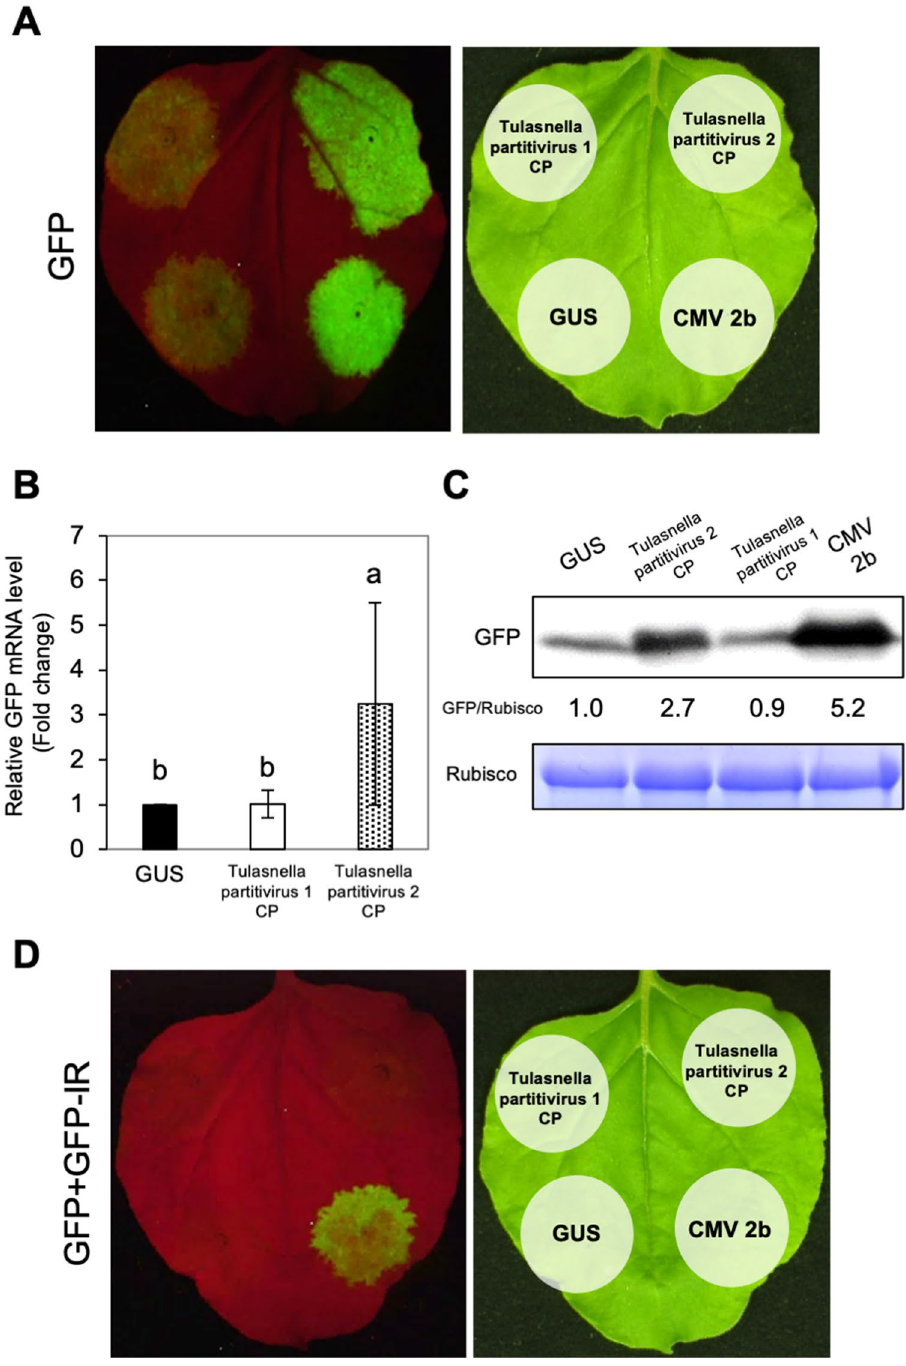
Figure 4. RSS activity of partitivirus CPs derived from OM fungi. ( A ) Assessment of RSS activity of the partitivirus CPs against sense RNA-mediated GFP silencing. Tulasnella partitivirus 1 CP or Tulasnella partitivirus 2 CP was expressed with GFP in N. benthamiana leaves by agroinfiltration. RSS activity of partitivirus CPs was assessed by comparing GFP intensities under UV light at 5 days post agroinfiltration (dpa). ( B ) Real-time RT-PCR for comparison of relative GFP transcript levels. The leaf samples from agroinfiltrated patches were collected at 5 dpa. Data were compared as values of fold-change relative to the control (GUS), and the values were analyzed on log-transformed data by Tukey’s multiple test (* P < 0.05). Means and confidence intervals are shown in the graph. Different letters above the bars indicate a significant difference among the experimental groups. ( C ) Western blot analysis to compare GFP levels using anti GFP antibodies. The Rubisco large subunit (Rubisco) is shown as a loading control for each sample. ( D ) Assessment of RSS activity of the partitivirus CPs against dsRNA-mediated GFP silencing. Each partitivirus CP was expressed with GFP and GFP-IR in N. benthamiana leaves by agroinfiltration. The GFP intensities were observed under UV at 2